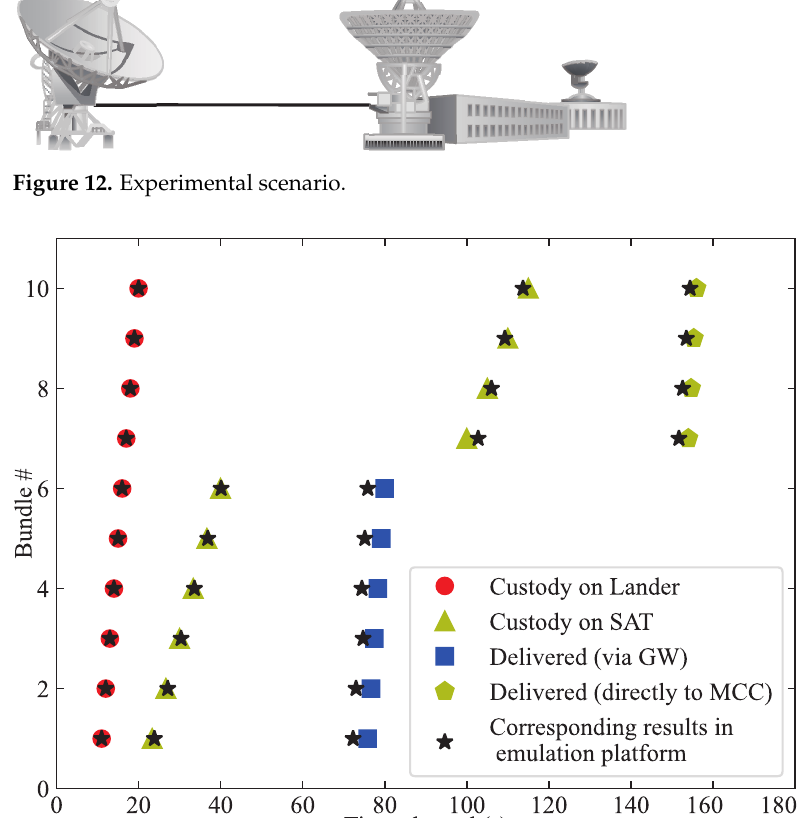
Figure 13. Bundle transfer from lander to MCC (Markers: from [33], star: emulation